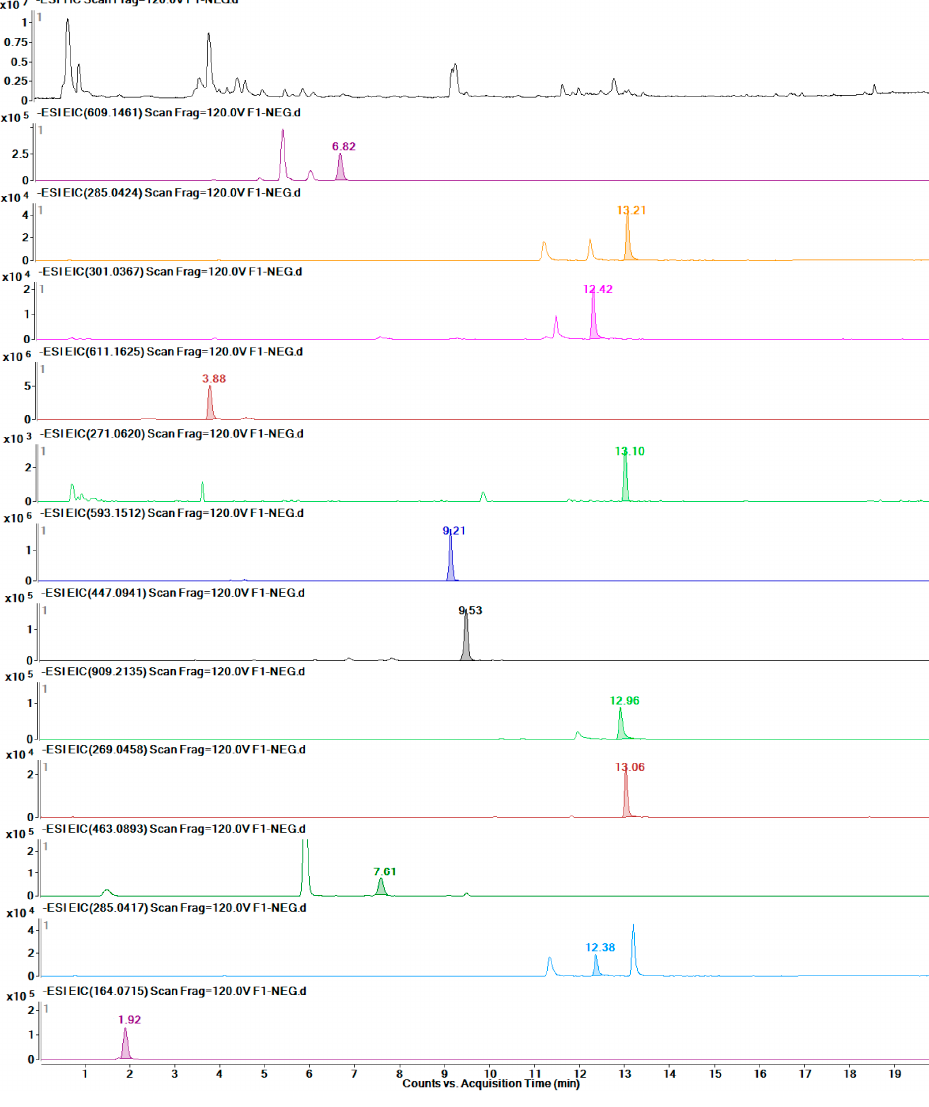
Figure 9. TIC of the F part and EICs of each of the twelve metabolites.